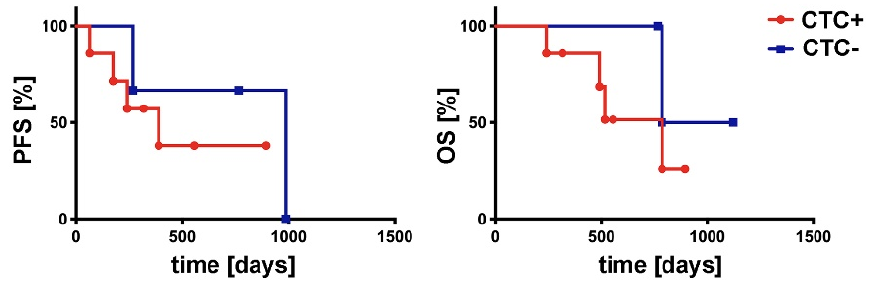
Figure 5. CTC status and survival.